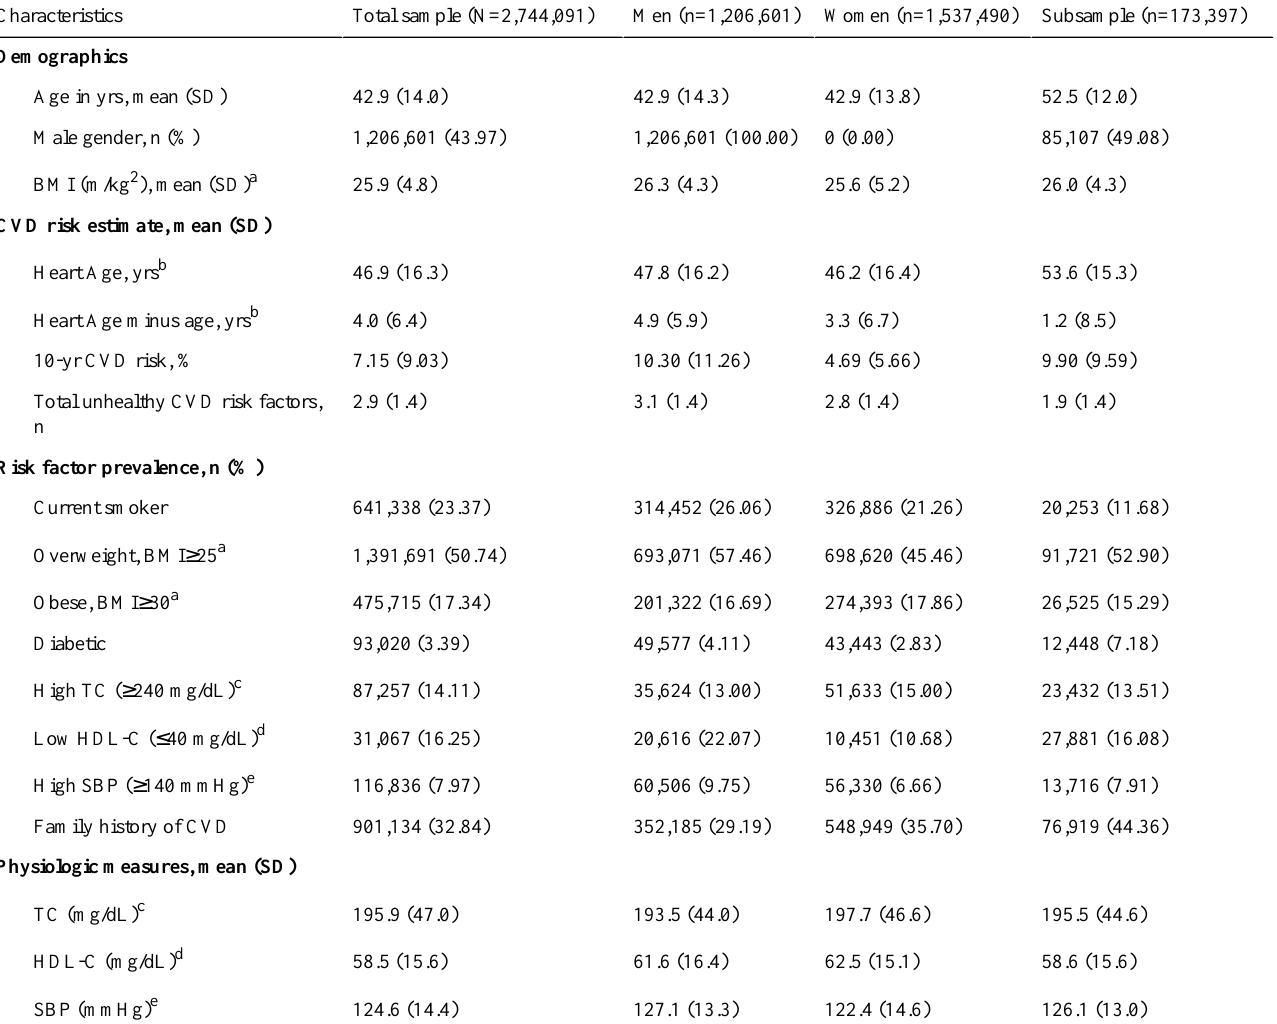
Table 1. Characteristics of users of the Heart Age tool, per gender and for a subsample of users with complete valid values for TC, HDL-C, and SBP.